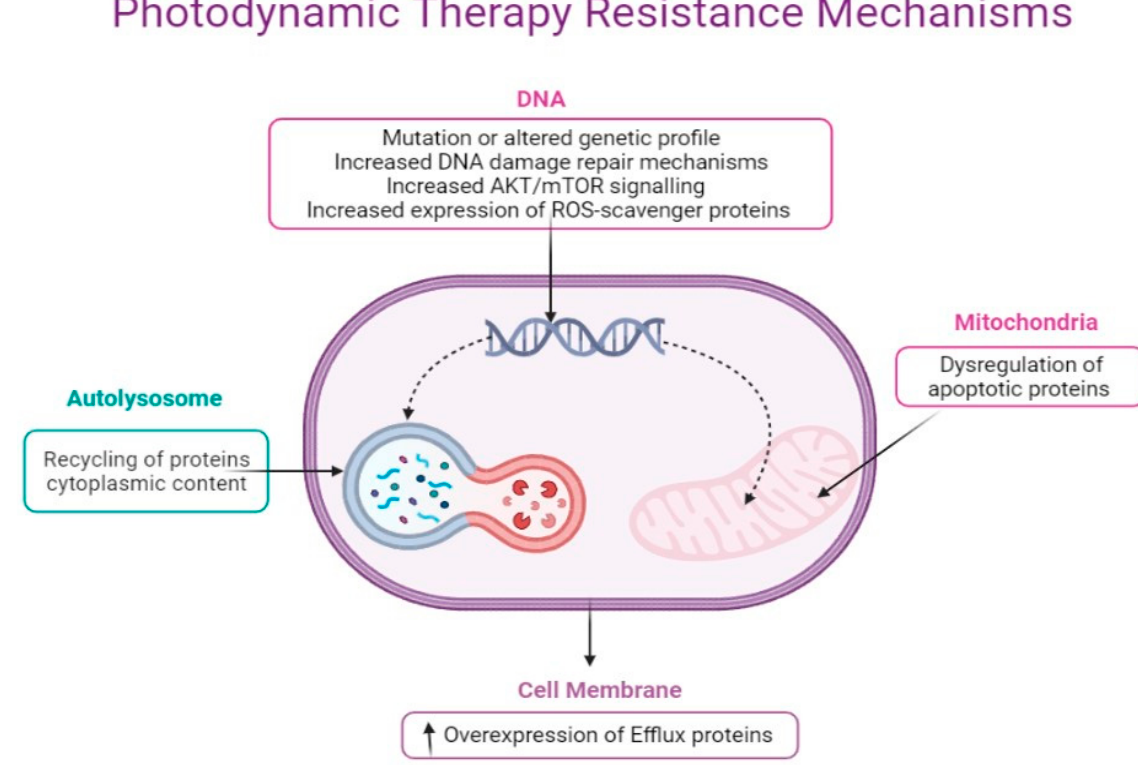
Figure 3. Cancer cells develop resistance to Photodynamic therapy through altered genetic profiling, increase in DNA damage repair mechanism, increase in AKT/mTOR signaling and expression of ROS-scavenger proteins. In the mitochondria, PDT can lead to dysregulation of antiapoptotic Bcl-2 protein at the cell membrane, overexpression of efflux proteins such as the P-glycoproteins, and autolysosome formation through recycling of cytoplasmic content for cell survival.